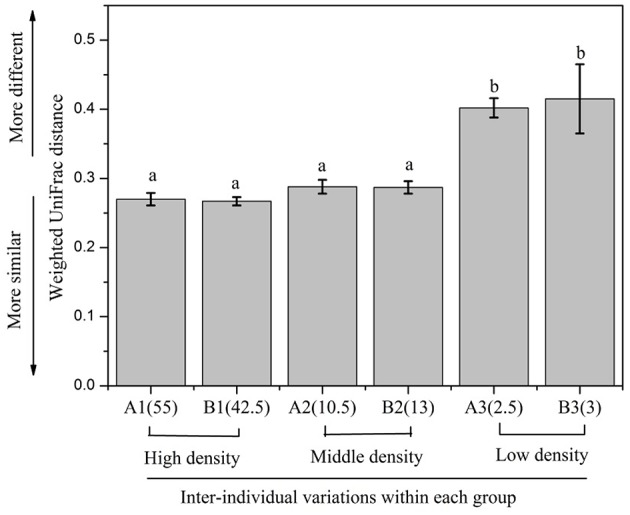
The inter-individual variations of gut microbiota within each group. The significance is indicated by different letters (P < 0.001, one-way ANOVA).